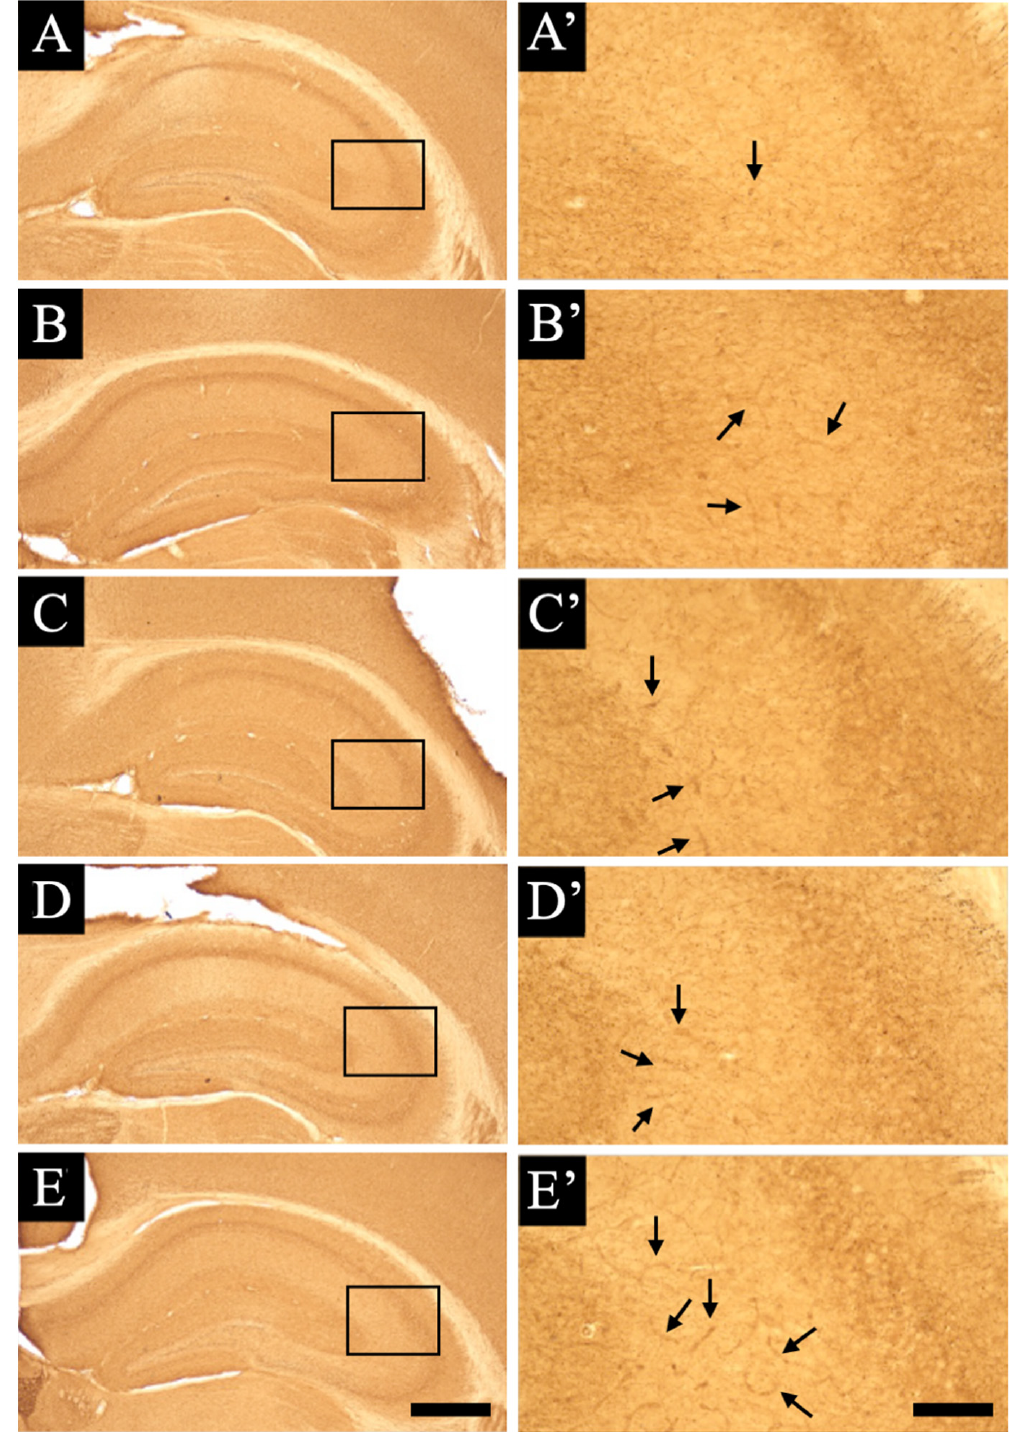
Figure 4. Choline acetyltransferase staining sections are shown: ( A – E ) are the lower magnification views, and ( A’ – E’ ) are the higher magnification views. ( A – E ) indicate the choline acetyltransferase- stained hippocampal sections of the vehicle-treated animals ( A , A’ ), piracetam-treated animals ( B , B’ ), aniracetam-treated animals ( C , C’ ), piracetam and α -GPC-treated animals ( D , D’ ), aniracetam and α -GPC-treated animals ( E , E’ ), respectively. Arrows indicate the choline acetyltransferase immuno-positive staining of blood vessels. Scale bars in ( E , E’ ) = 500 μ m and 100 μ m, respectively.